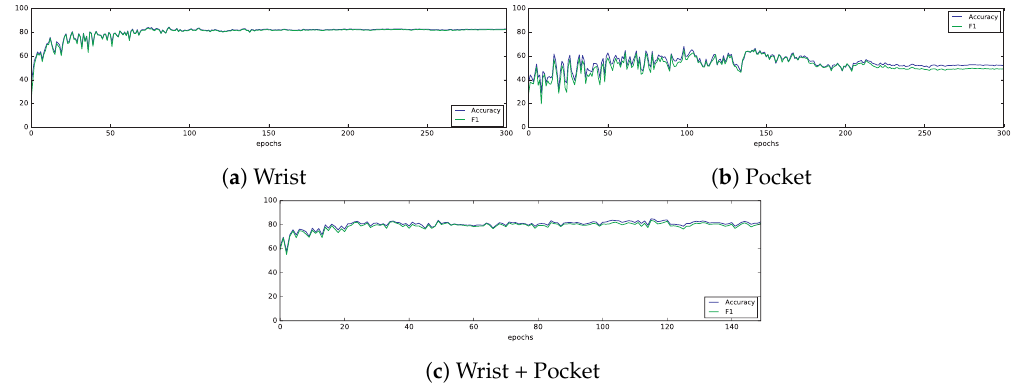
Figure 12. Evolution of test accuracy and F1 score along the training epochs.